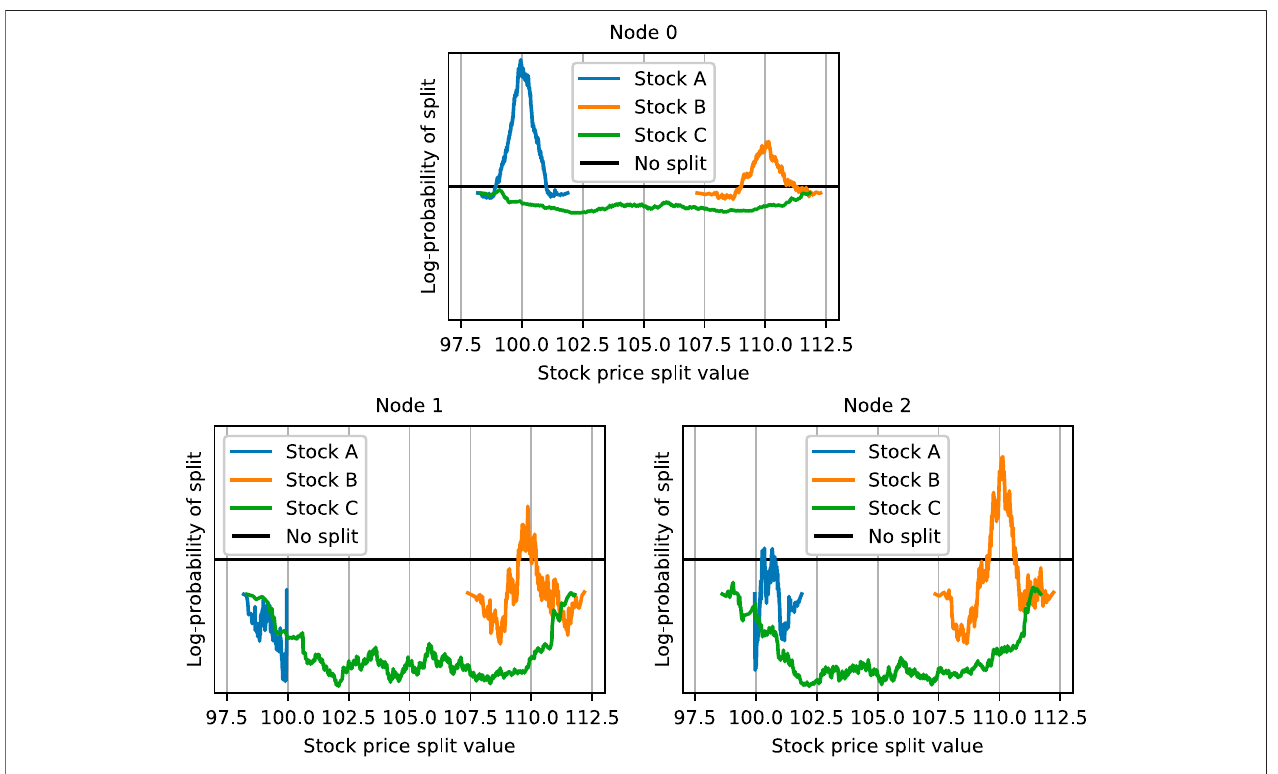
FIGURE 5 | Log-probability of S r , h at each sprout for the trading example. The black horizontal line indicates the S 0 log-probability.